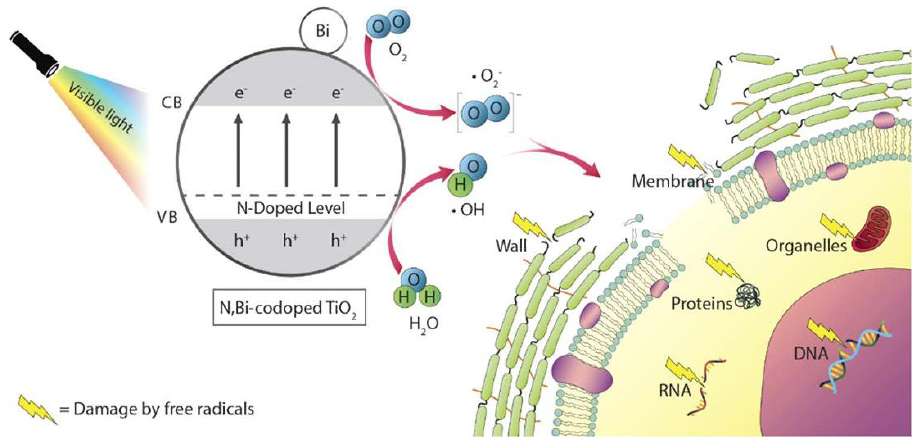
Figure 3. The possible mechanisms of photocatalytic antibacterial activity of N, Bi-codoped TiO 2 . Reproduced with permission from ref